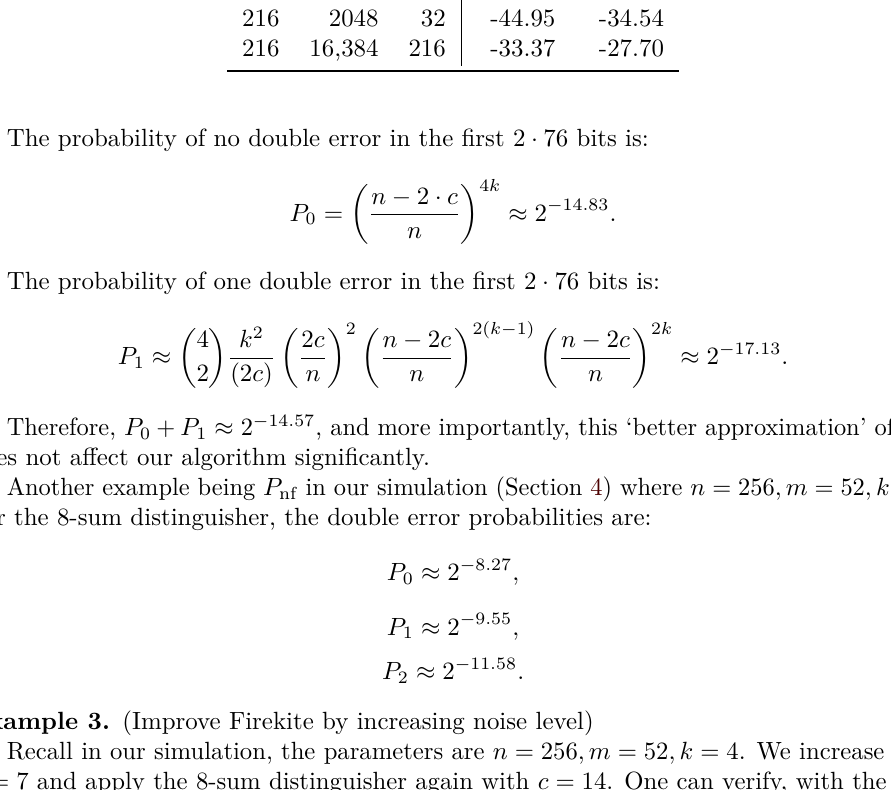
) probabilities for some 1